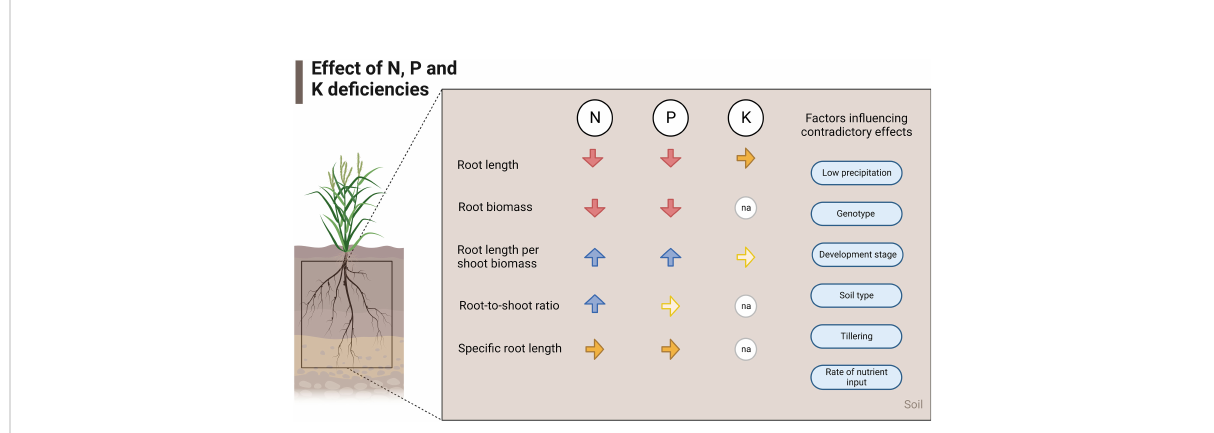
FIGURE 5 Effects of N, P, and K de fi ciencies at fi eld scale. The red arrows show a decrease, the blue arrows show an increase and the yellow arrows show similarity in that trait in case of de fi ciency of the respective nutrient. Lighter-colored arrows stand for few studies found investigating that speci fi c parameter (2-4 studies), and na stands for not applicable.